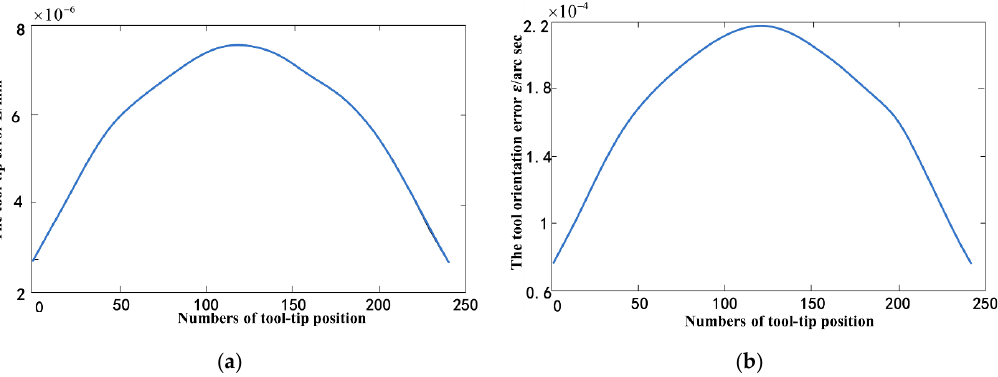
Figure 15. Deviation errors of tool-tip position and tool orientation after compensation. ( a ) Tool-tip position error after compensation. ( b ) Tool axis orientation error after compensation.